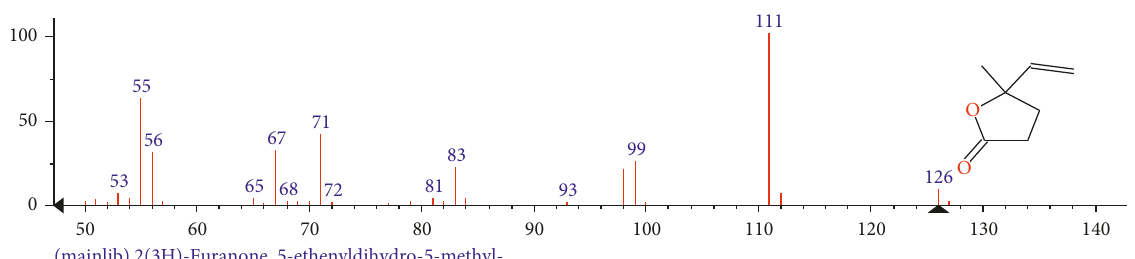
Figure 2: Mass spectrum of compound 2(3H)-furanone, 5-ethenyldihydro-5-methyl- of whole plant hexane fraction of Achillea wilhelmsii (WHFAW).